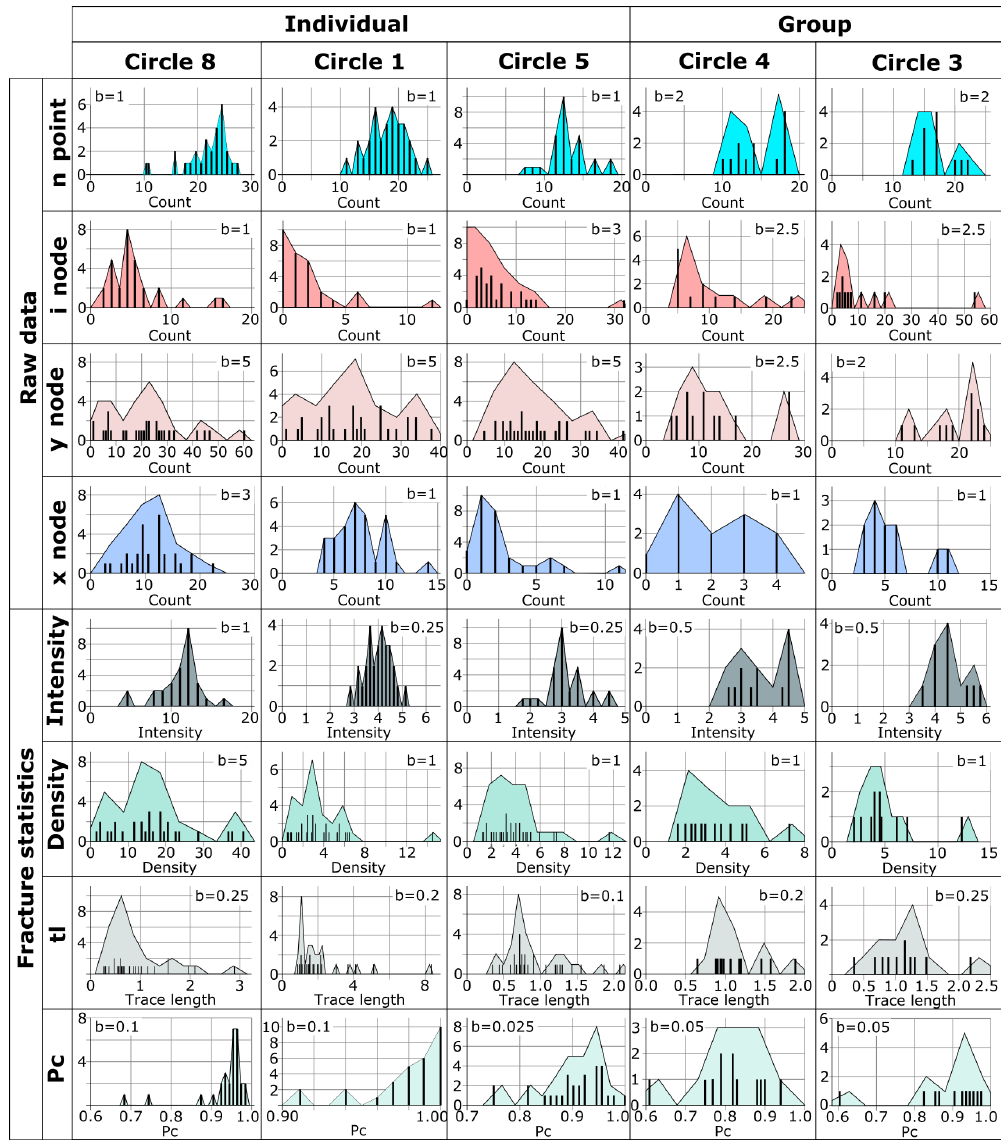
Figure 9. Topological sampling results for individuals and groups for circular scanlines 1, 3, 4, 5, and 8. Each histogram reports the results for all workshop participants. The statistics have been derived from the data for each participant. Data are presented as both bar charts and shaded histograms with the bin width, b , indicated on the chart (please note the bin width varies between circles as a function of the range in reported or calculated values). In all cases the y axis represents frequency and is scaled so the shape of the distributions can be